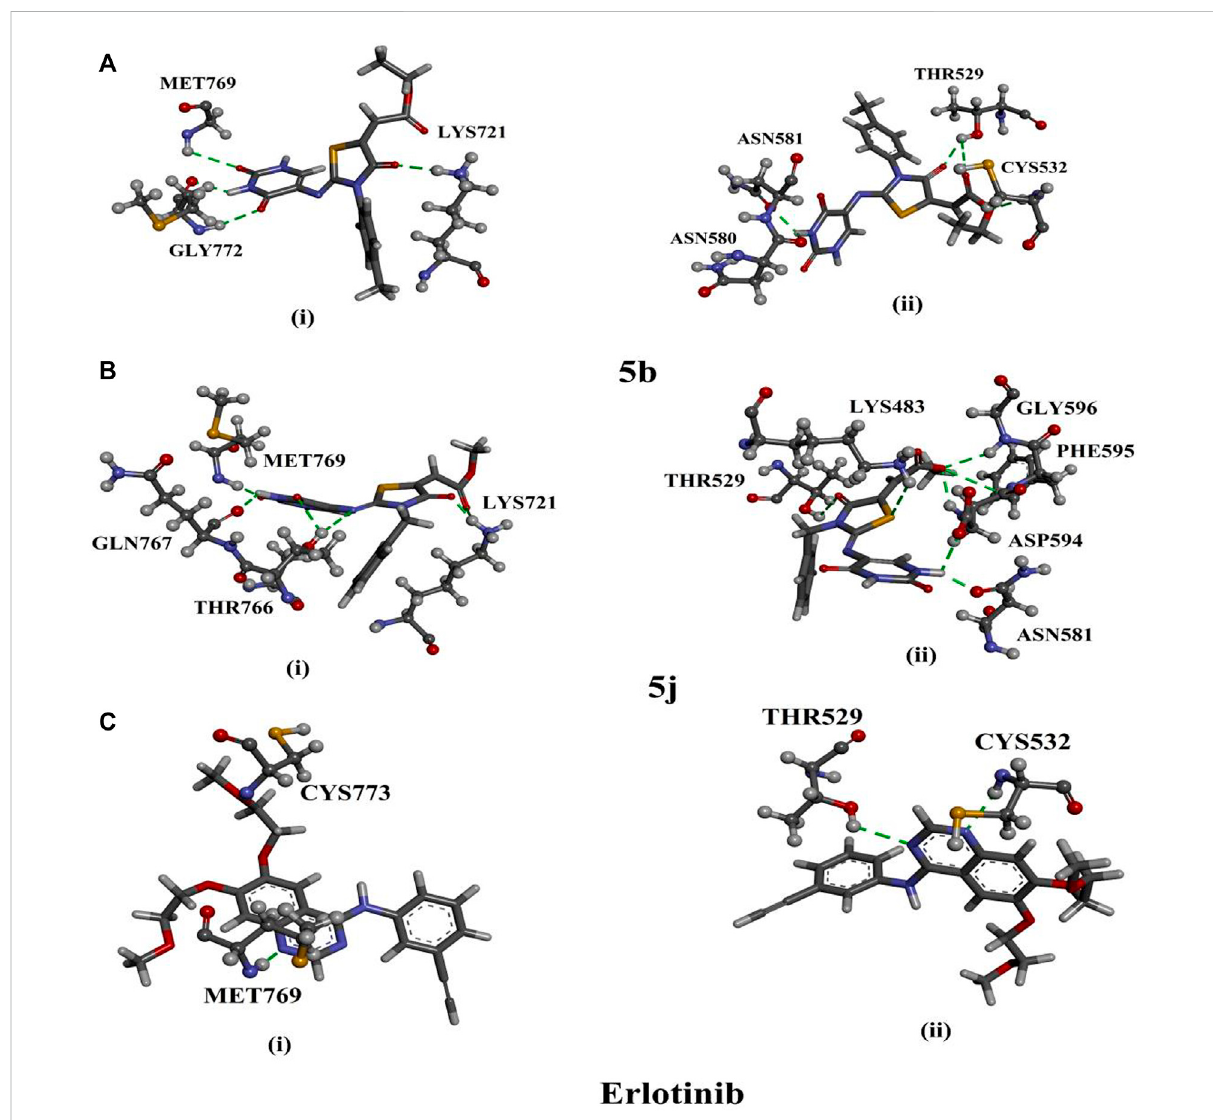
FIGURE 9 3D representations of interactions of compounds (A) 5b , (B) 5j , and (C) erlotinib with key residues of (i) EGFR and (ii) BRAF V600E